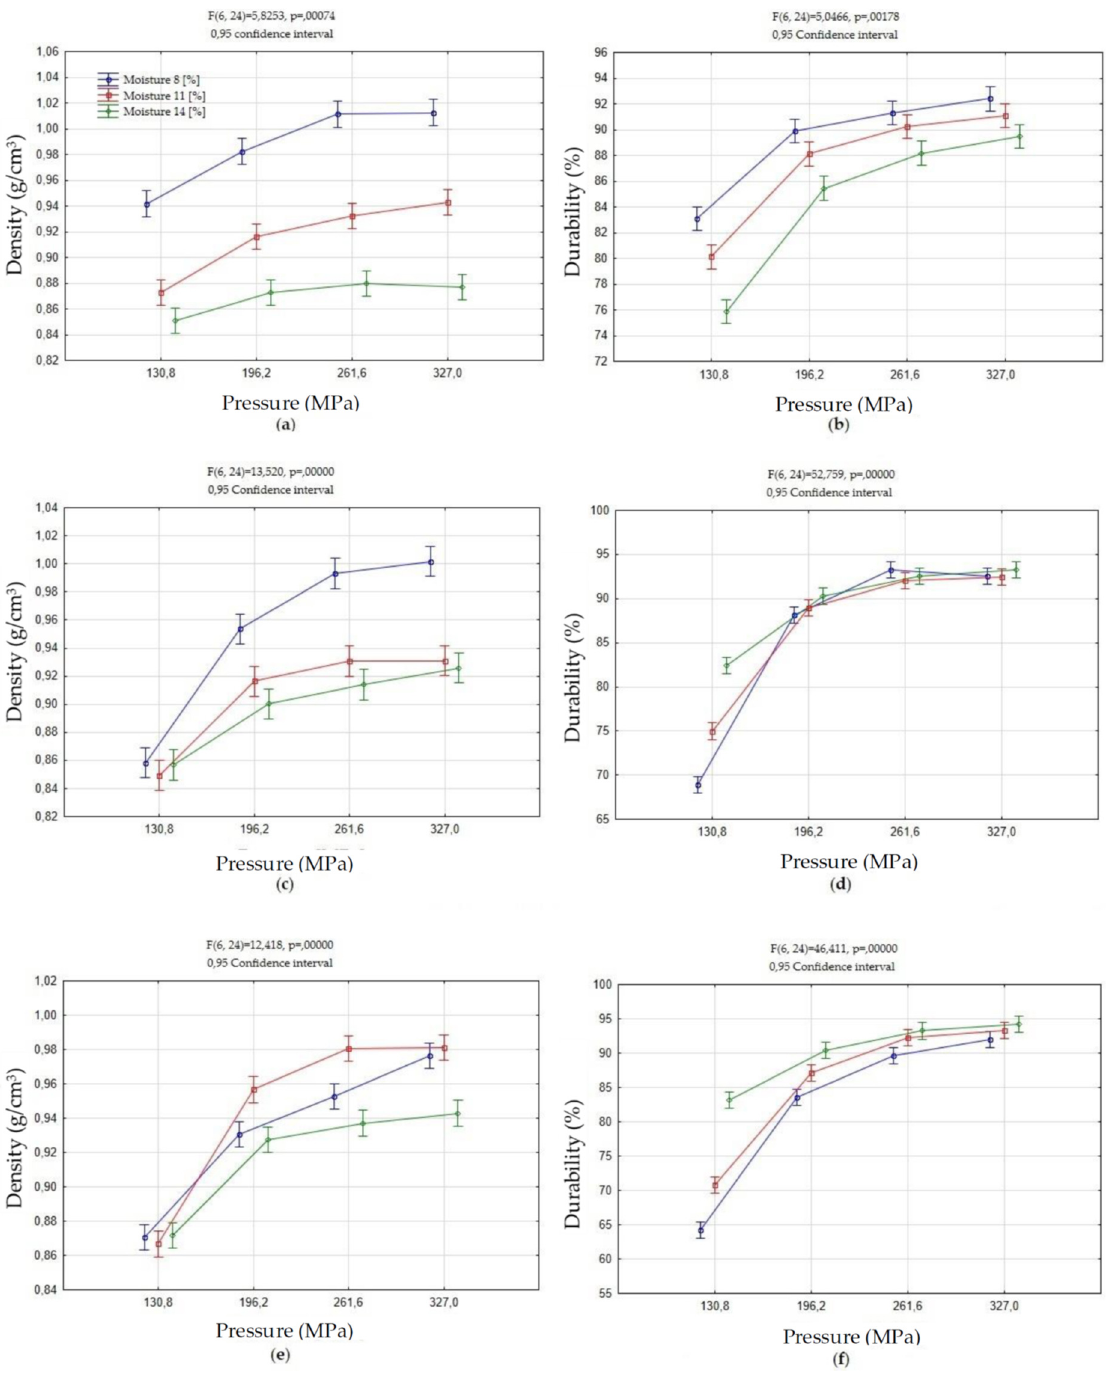
Figure 9. Influence of moisture and pressure on: ( a ) Miscanthus DE, ( b ) Miscanthus DU, ( c ) Silphium DE, ( d ) Silphium DU, ( e ) Sida DE, ( f ) Sida DU.